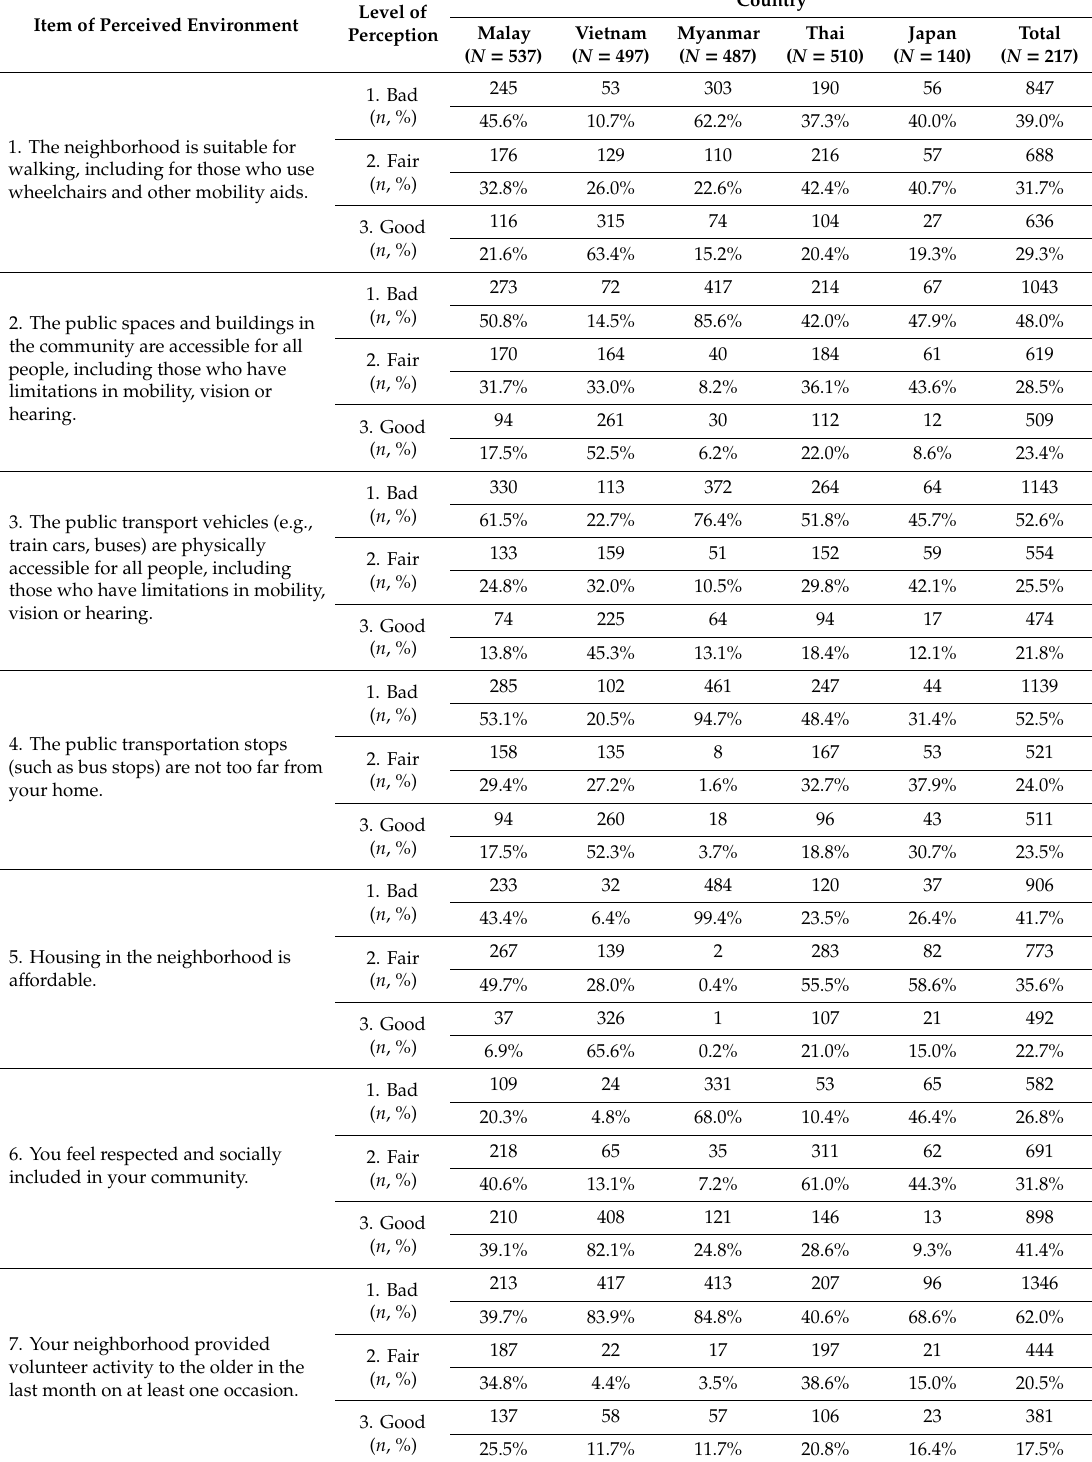
Table 3. The levels of perceived age-friendly environments by country (applied Pearson chi-squared test